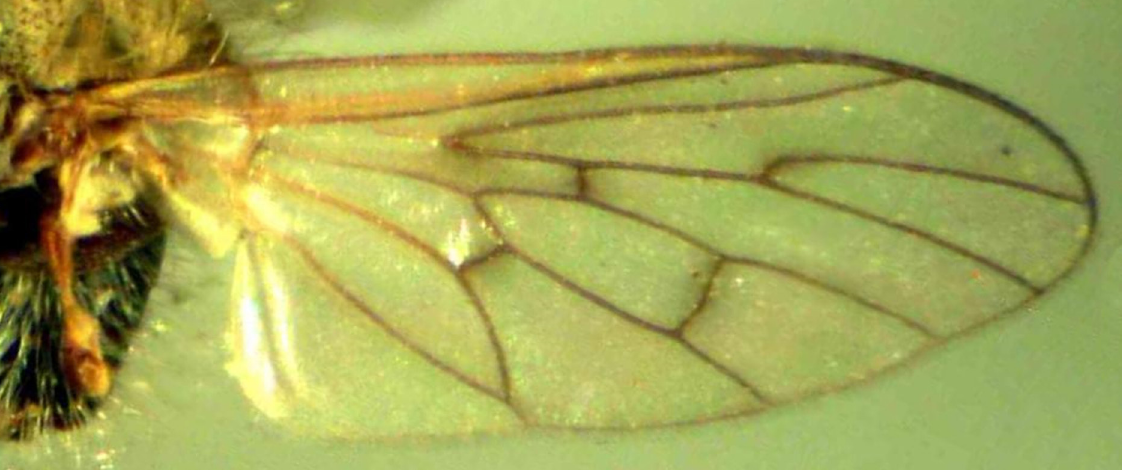
Fig. 8. Protypusia vagans (Becker, 1906) gen. et comb. nov., ♂.